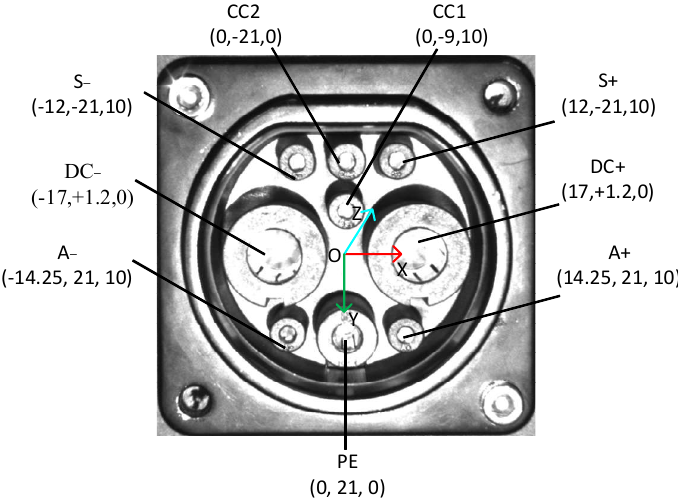
Figure 1. Internal structure diagram and relative position coordinates of a CP.